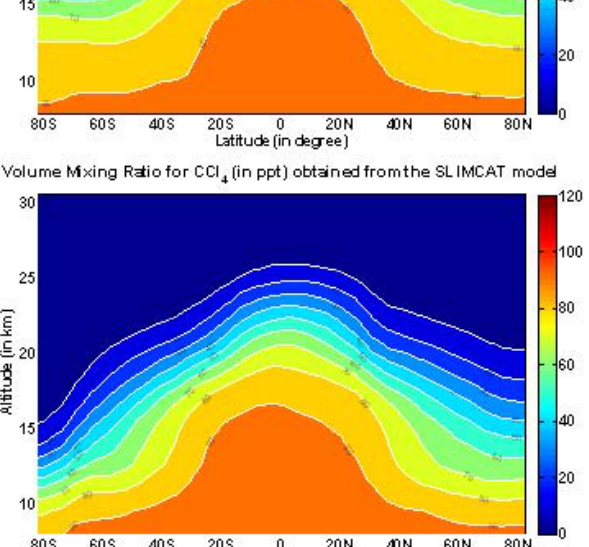
Fig. 8. The zonal mean annual mean latitude-height distribution of carbon tetrachloride VMR (ppt) from (a) the AER 2-D model, (b) the GMI 3-D model and (c) the SLIMCAT 3-D model.